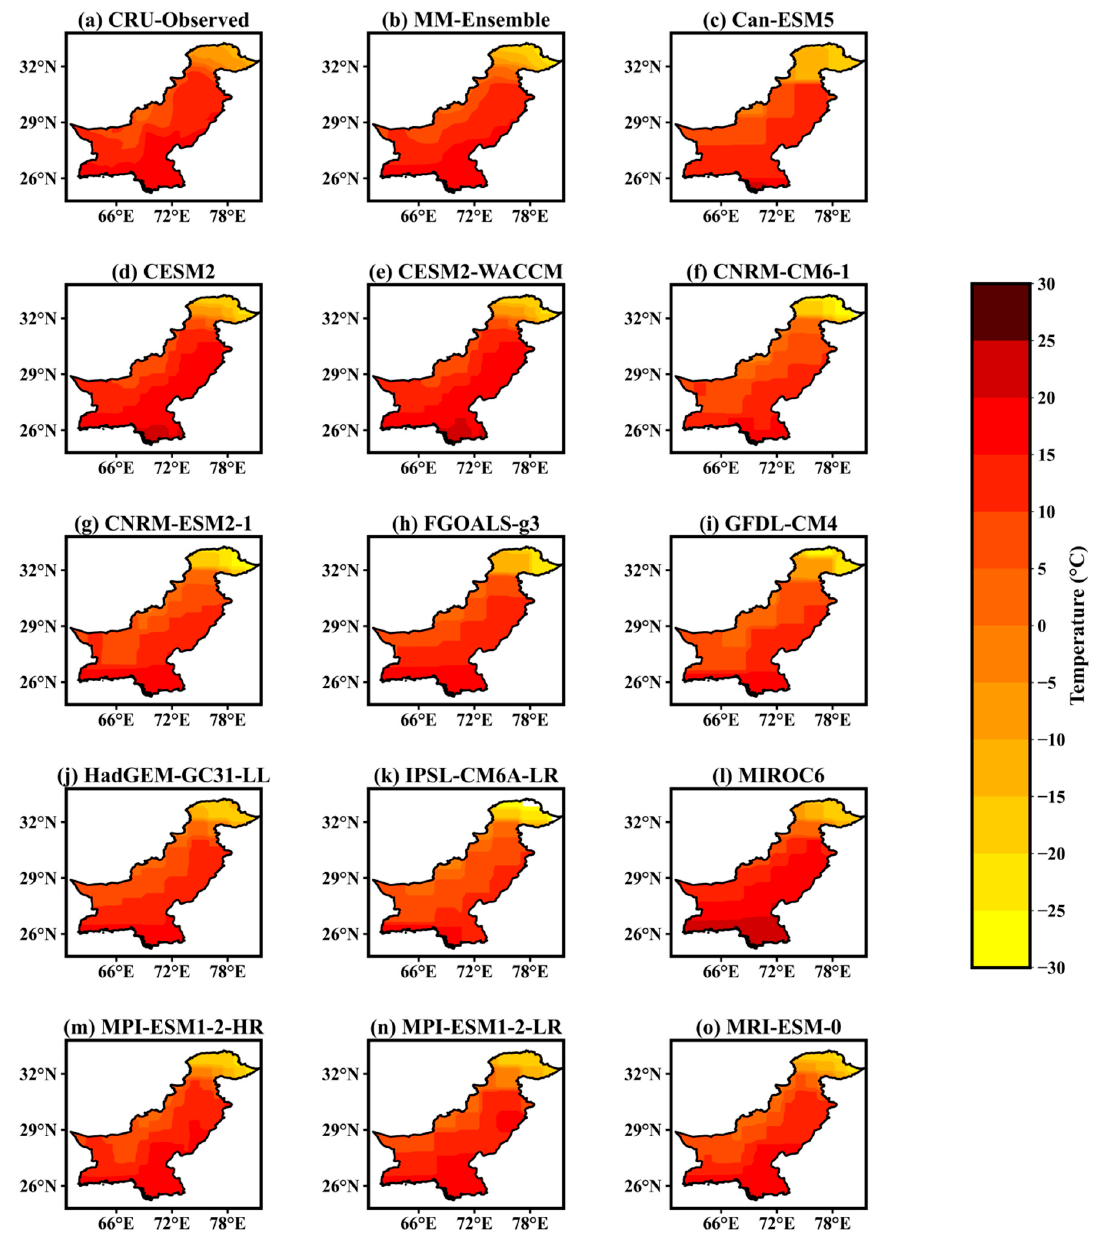
Figure 4. Same as Figure 3 but for winter (December–January–February (DJF)) season.